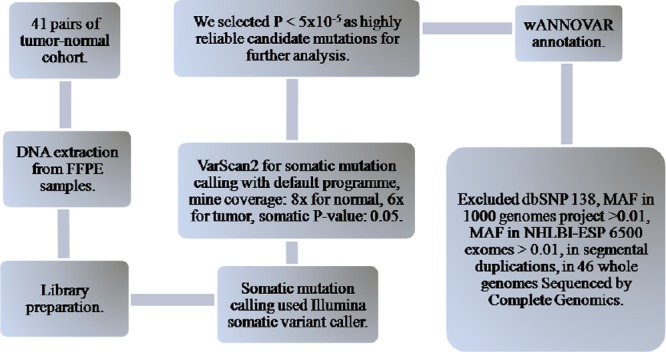
Flowchart of the data analysis strategy.